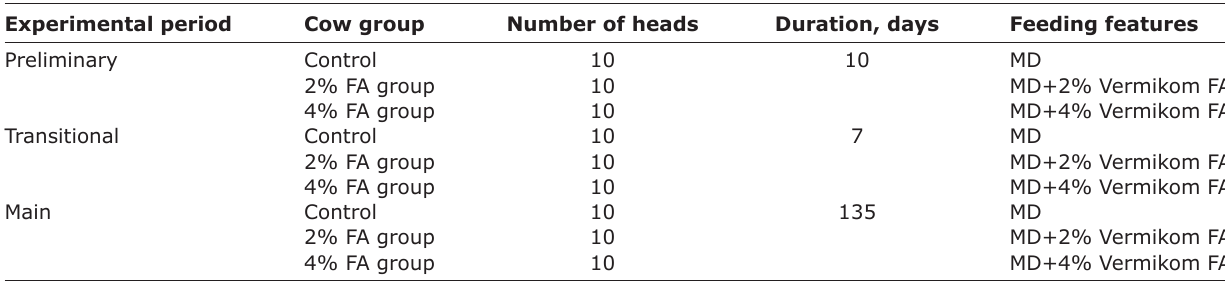
Table-2: Scheme of the experiment. Experimental